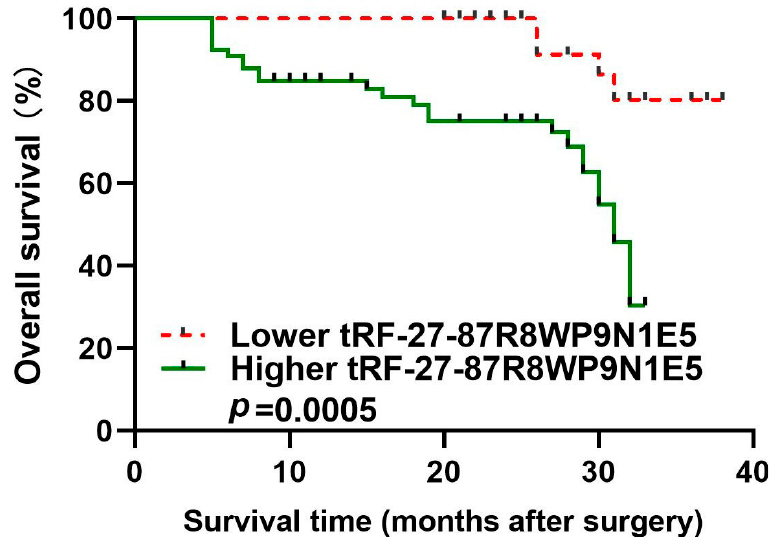
Figure 7. Prognostic value of tRF-27 in gastric cancer patients. High tRF group ( n = 66); low tRF group ( n = 40). High tRF group: tRF-27 expression was greater than or equal to 724,807 copies/mL. Low tRF group: tRF-27 expression level was lower than 724,807 copies/mL.